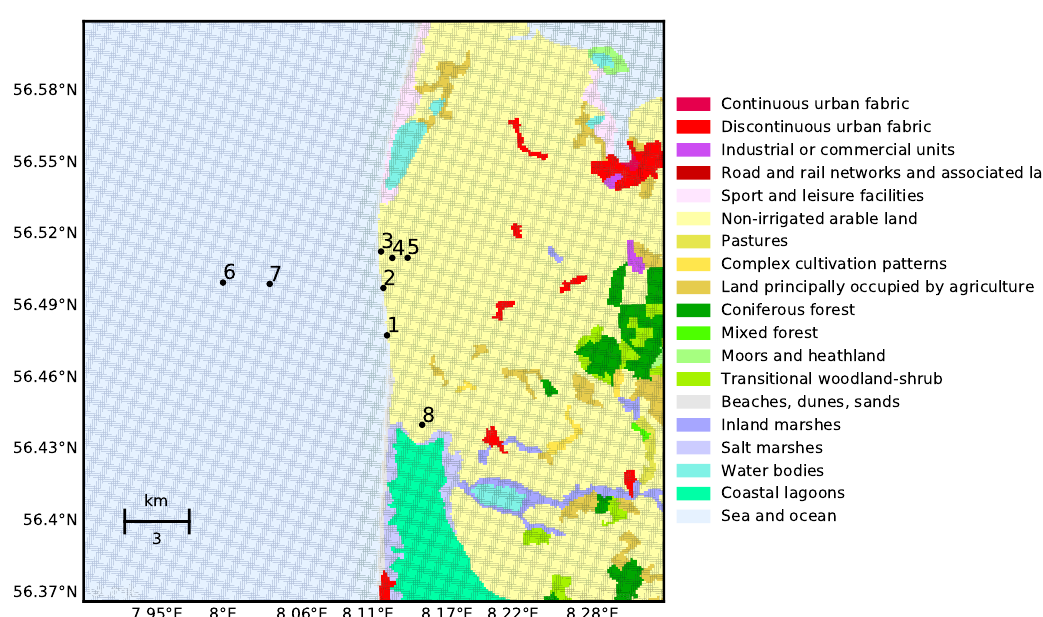
Figure 3. Land-use description of the terrain around the RUNE site. The main positions described in Section 3 are also given